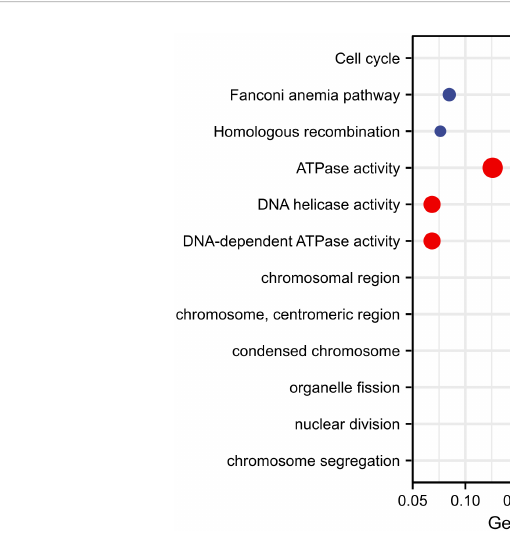
FIGURE 5 Pathway enrichment analysis of CENPL.